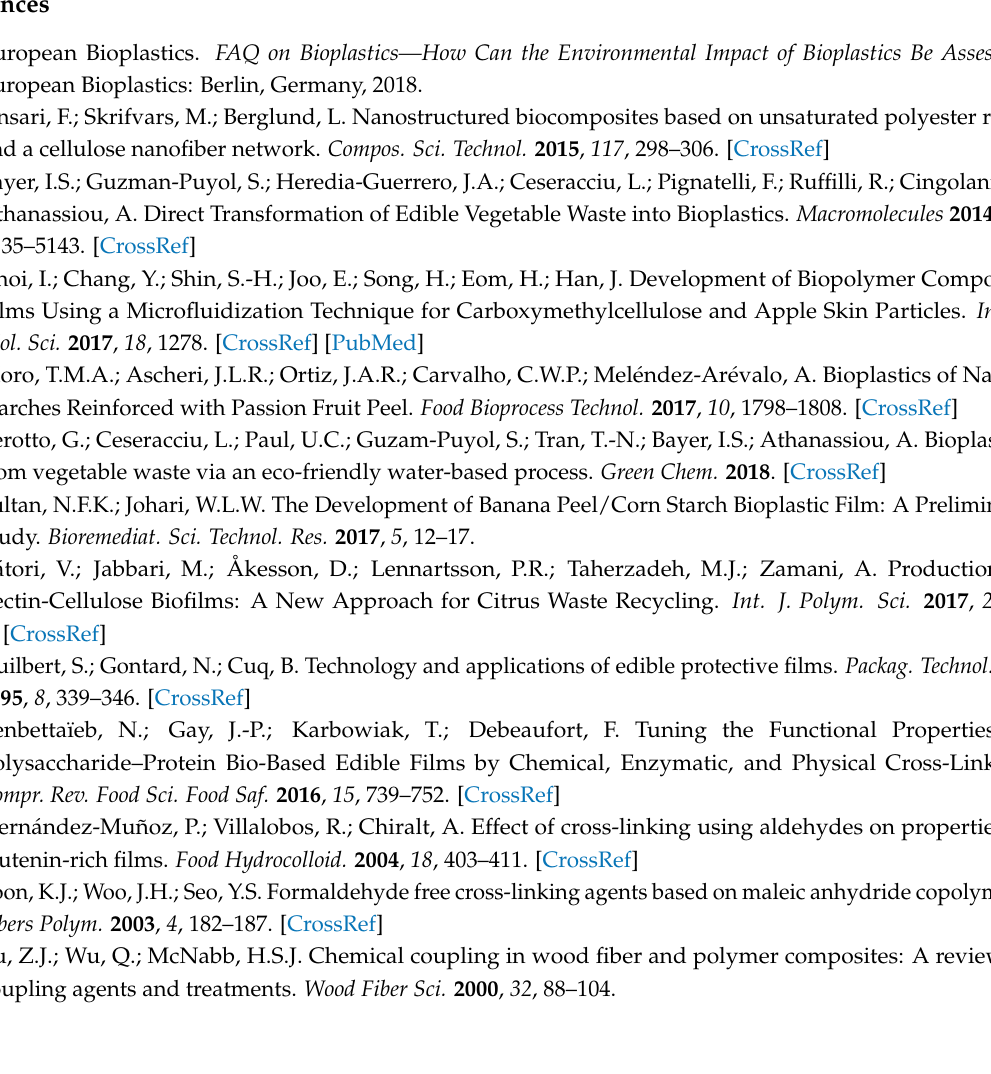
Figure S1: FE-SEM micrographs of film surfaces with a magnification of 1.00 K × (a) and 5.00 K × (b) and cross-sectional images with a magnification of 1.00 K × (c) and 10.00 K × (d) containing the highest concentrations of glycerol and sugar and the lowest concentration of MA (0.39%); film surfaces with a magnification of 1.00 K × (e) and 5.00 K × (f) and cross-sectional images with a magnification of 1.00 K × (g) and 10.00 K × (h) containing the highest concentrations of glycerol and sugar and the middle level of MA concentration (0.78%); film surfaces with a magnification of 1.00 K × (i) and 5.00 K × (i) and cross-sectional images with a magnification of 1.00 K × (k) and 10.00 K × (l) containing the highest concentrations of glycerol and sugar and the highest concentration of MA